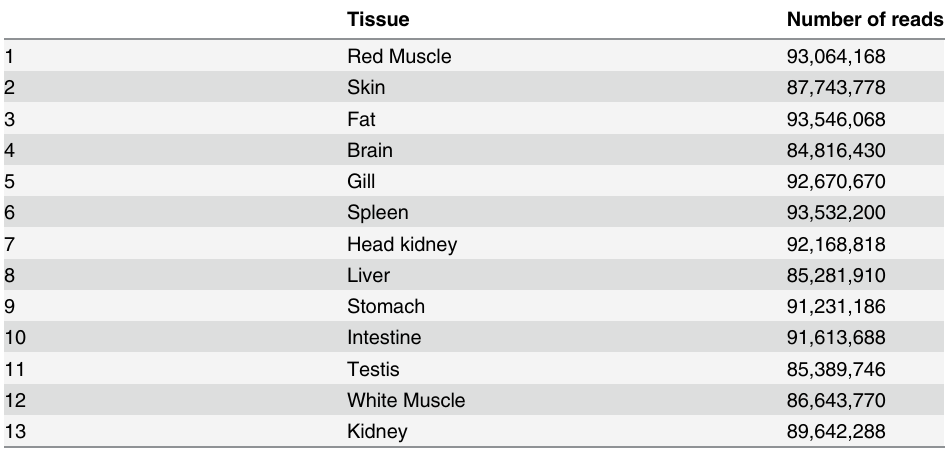
Tissue Number of